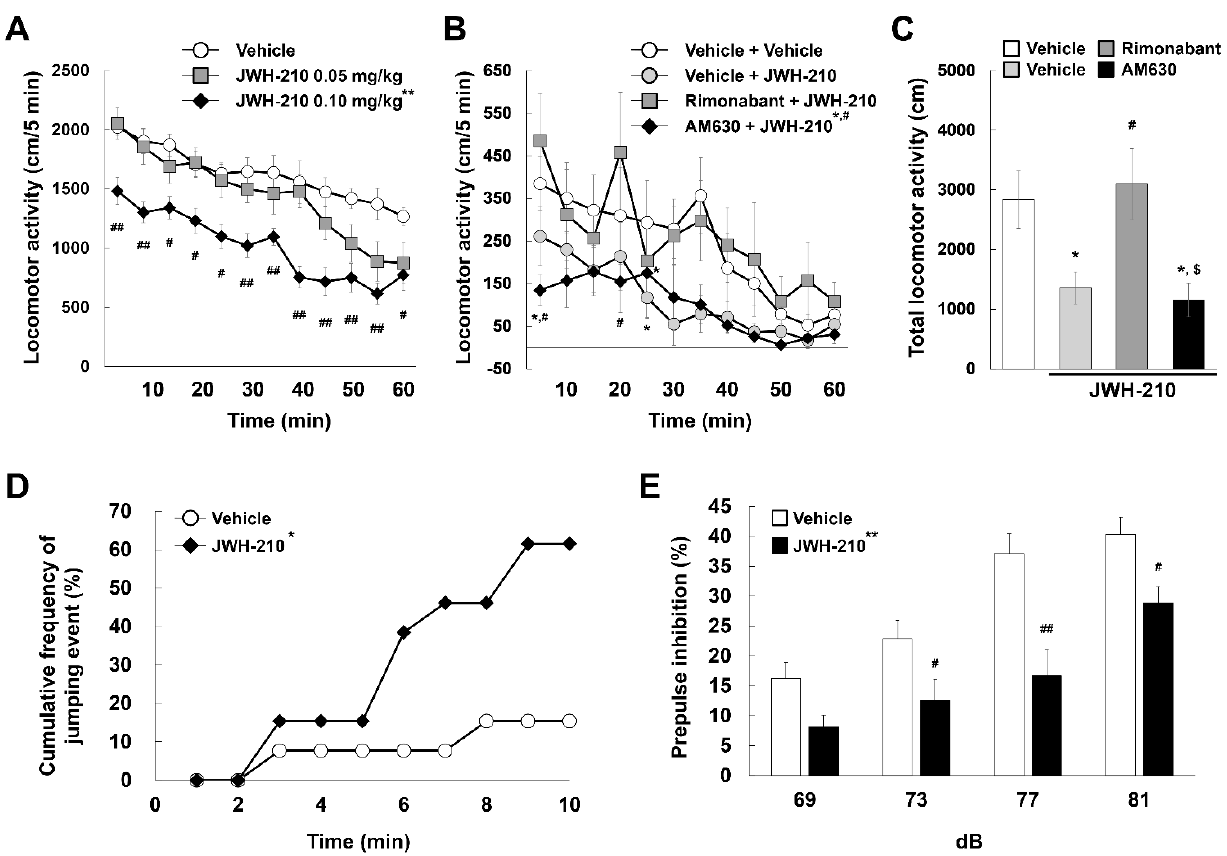
Figure 2. Effects of JWH-210 on behavioral tests. ( A ) Mice were injected with either vehicle or JWH-210 (0.05 or 0.1 mg/kg, i.p.). Locomotor activity was measured at 5 min intervals for 60 min. Data are expressed as the mean distance traveled ± S.E. ( n = 10) and were analyzed using two-way RM ANOVA followed by Bonferroni post-hoc t-test [ ** p < 0.01 vs. vehicle group; # p < 0.05 and ## p < 0.01 vs. vehicle group (at the same time point)]. ( B , C ) Mice were injected with either vehicle or rimonabant (CB1 antagonist, 1 mg/kg) or AM630 (CB2 antagonist, 3 mg/kg) 30 min prior to JWH-210 (0.1 mg/kg, i.p.) injection. ( B ) Locomotor activity was measured at 5 min intervals for 60 min. Data are expressed as the mean distance traveled ± S.E. ( n = 6–7) and were analyzed using two-way RM ANOVA followed by Bonferroni post-hoc t-test [ * p < 0.05 vs. vehicle + vehicle group (at the same time point); # p < 0.05 vs. rimonabant + JWH-210 group (at the same time point)].